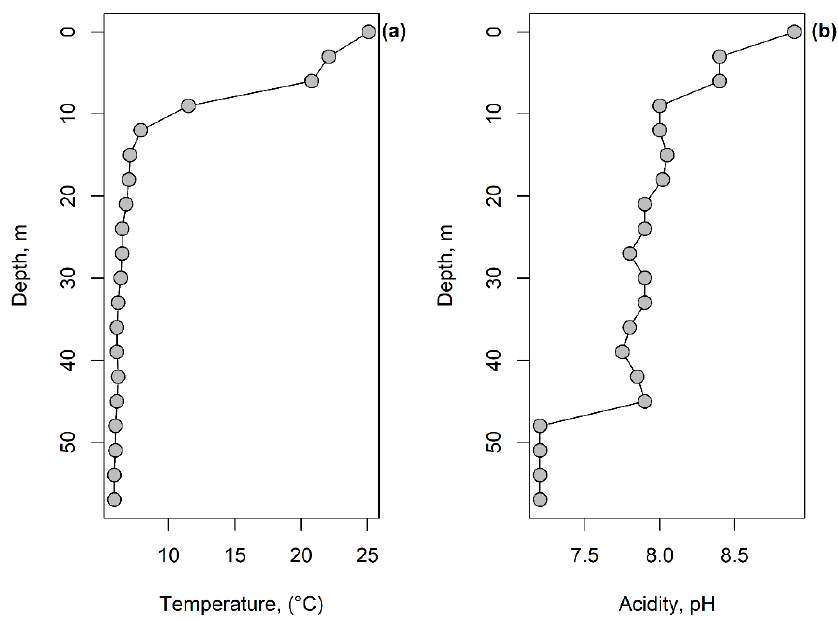
Figure 3. Variation of temperature ( ◦ C) ( a ) and pH ( b ) of near-bottom water along the depth gradient. Table 1. The list of testate amoeba genera with the number of species and counts along the transect.